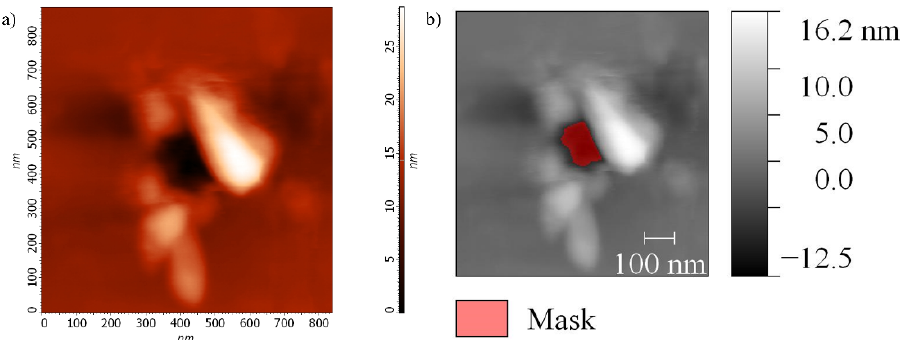
Figure 3. Semi-contact AFM image of an indent on HOPG surface ( a ); same image as in the upper panel after cropping and analysis with the software Gwyddion ( b ).